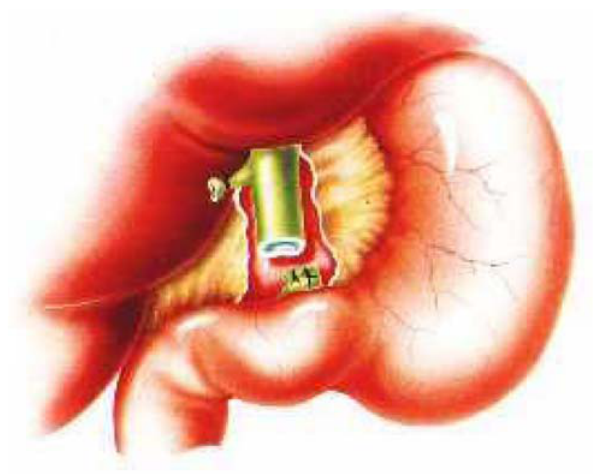
FIGURA 6 - Desenho mostra a anastomose do Grupo I concluída.